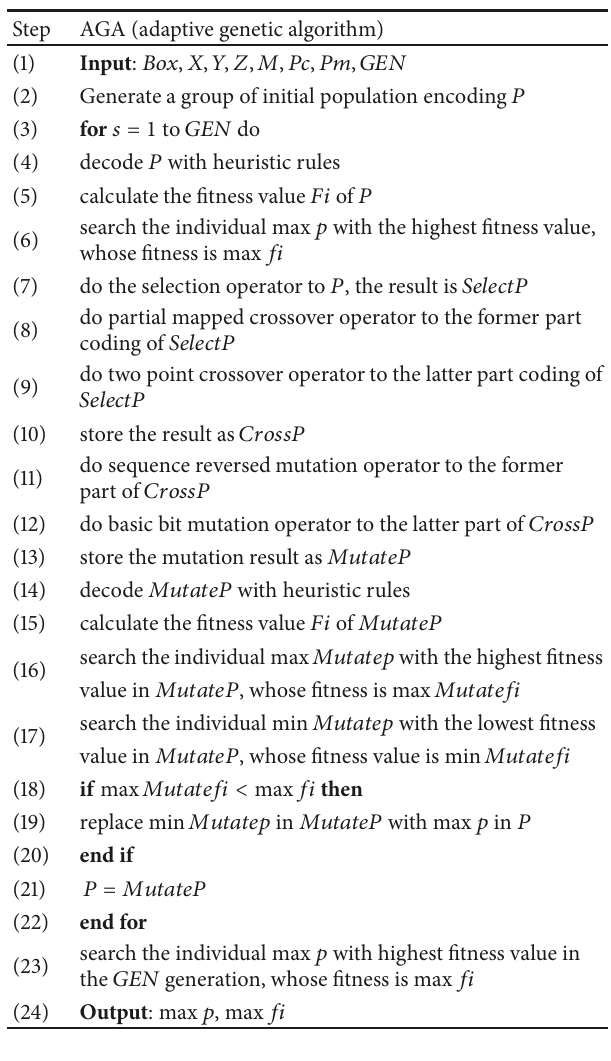
Table 2: Adaptive genetic algorithm.